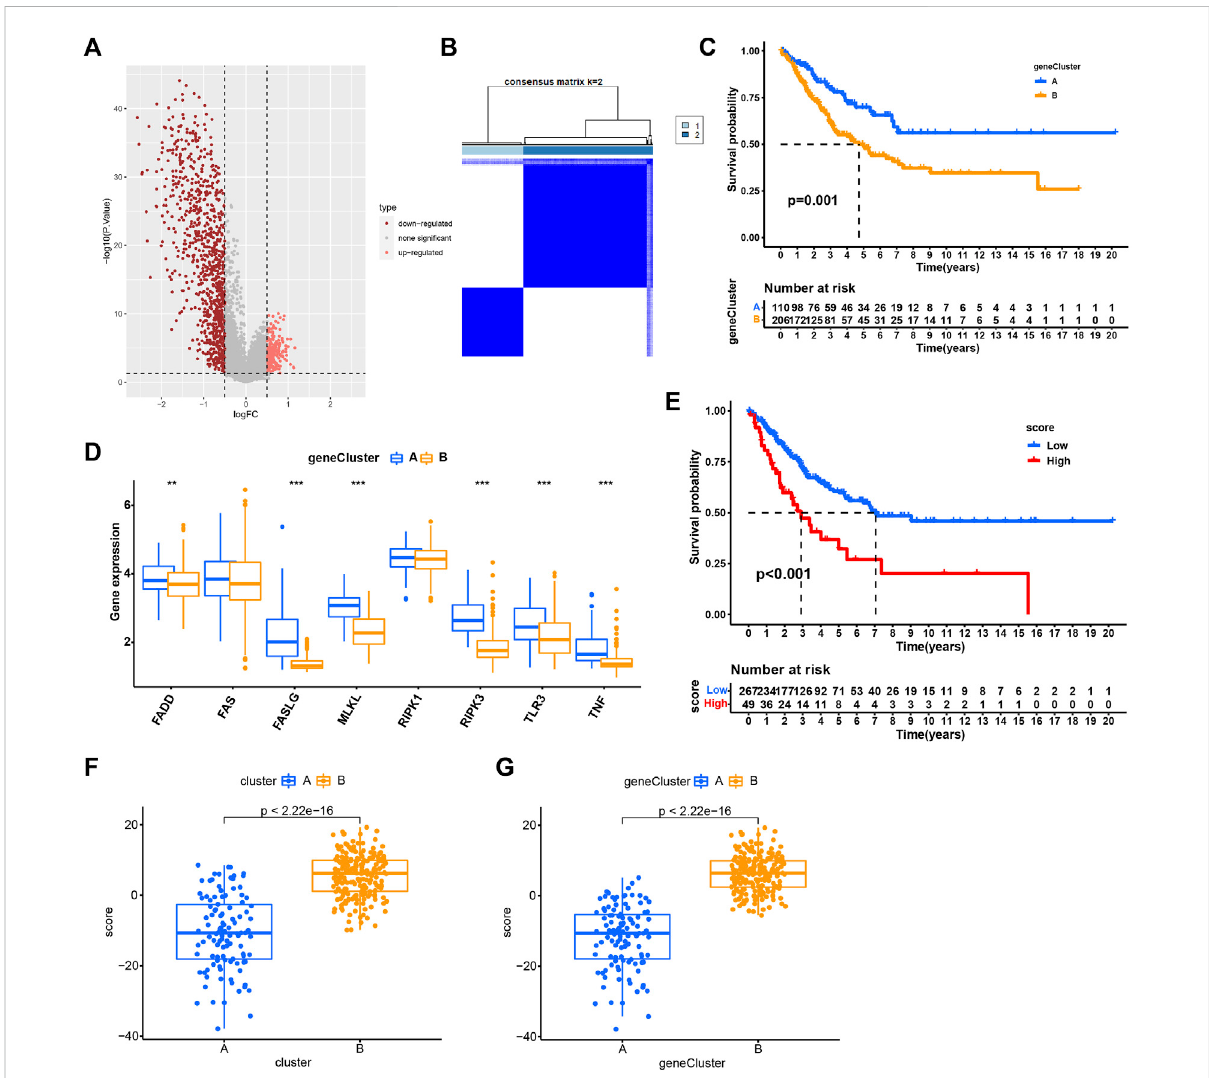
FIGURE 5 Identi fi cation of subtypes based on DEGs. (A) Volcano plotof 316 DEGs. (B) Consensus matrix heatmap when cluster number k = 2. (C) Kaplan- Meier analysis of SARC patients in two geneClusters. (D) The expression of necroptosis genes in two geneClusters. (E) Kaplan-Meier analysis of necroptosis score in SARC. (F – G) The necroptosis score in two clusters (F) and two geneClusters (G) . * p < 0.05, ** p < 0.01, *** p < 0.001, **** p <